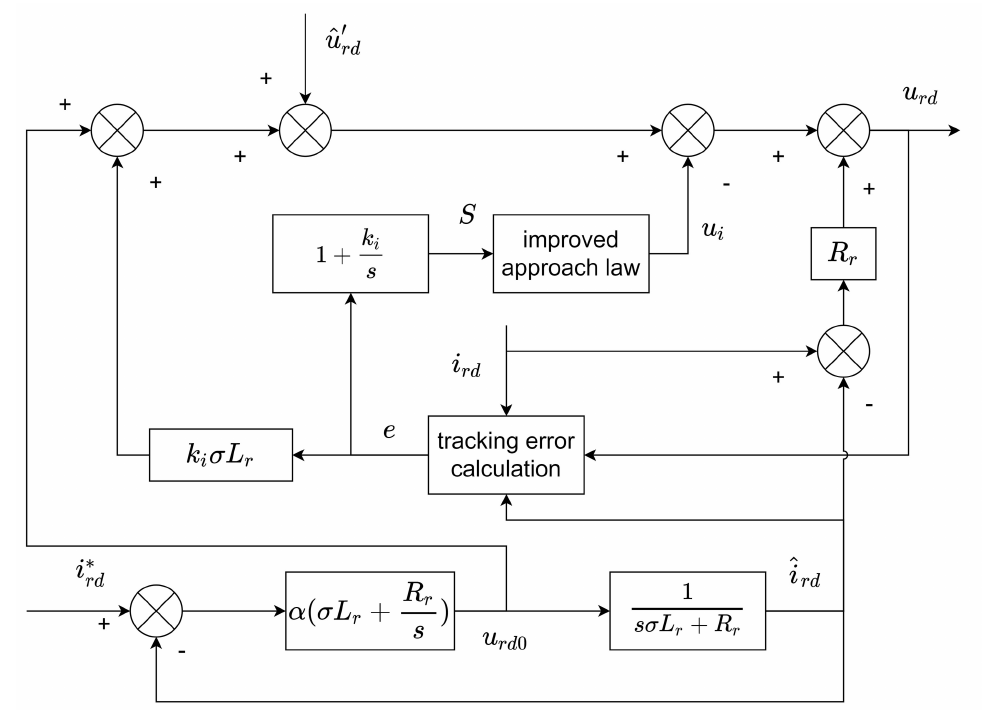
Figure 8. Description of block diagram of the